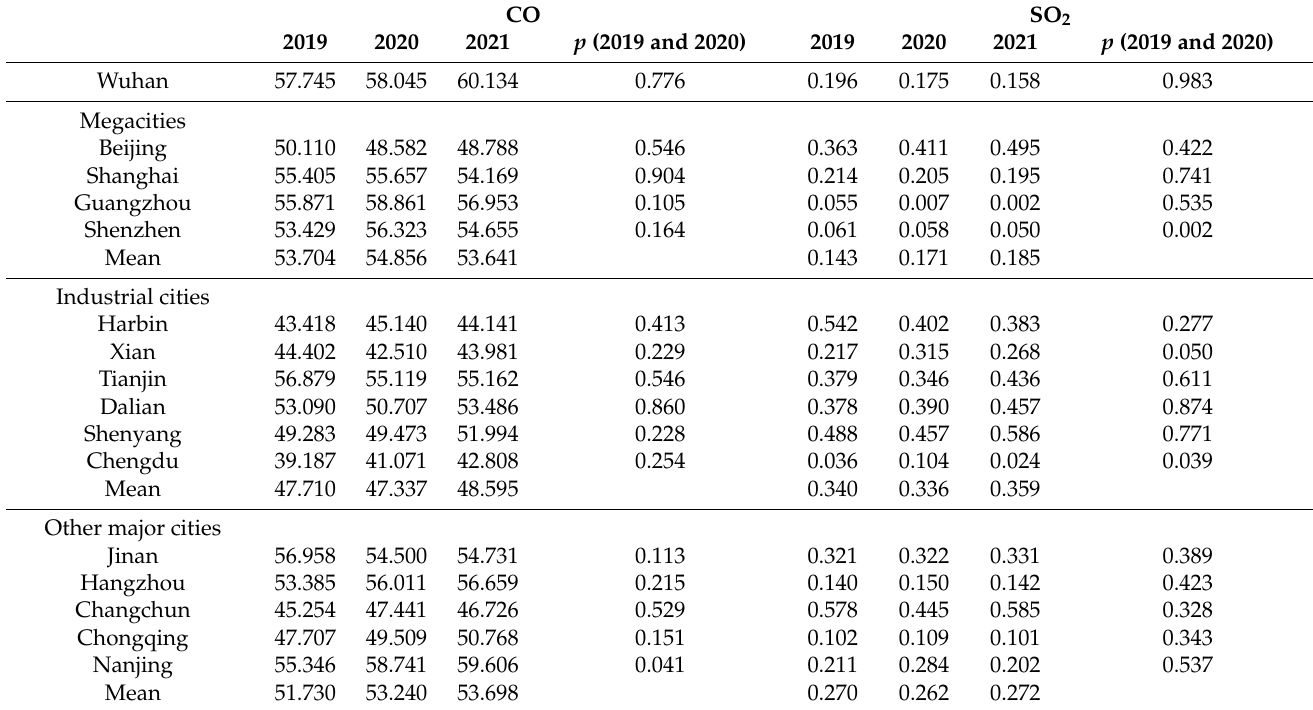
Table 5. Summary of CO and SO 2 concentration amounts (mmol/m 2 ), temporal changes, and non-parametric Wilcoxon Test results among different periods. CO SO 2